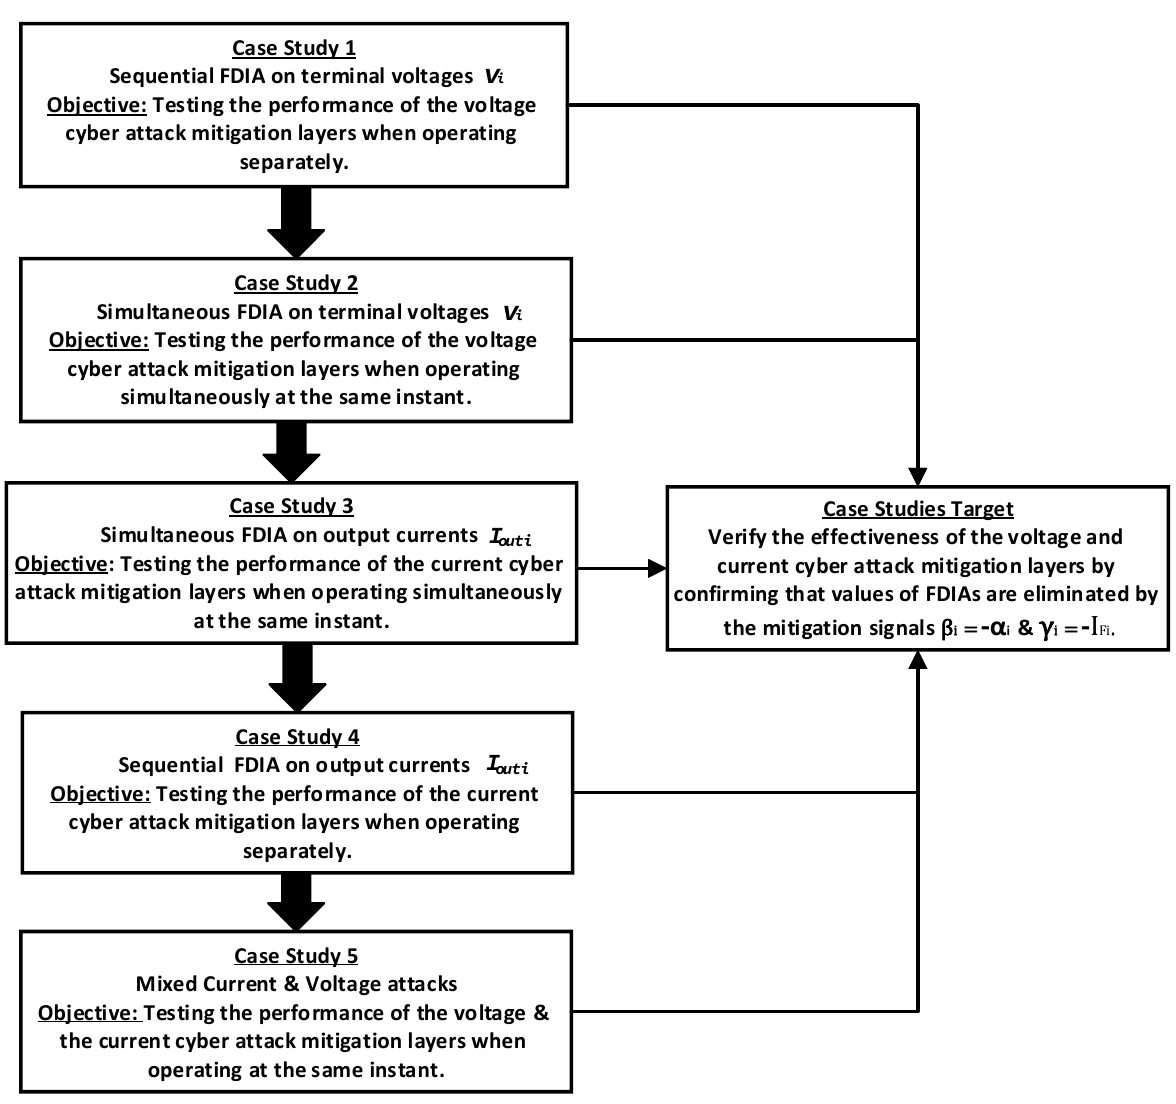
Figure 9. Simulation case studies: objectives and targets.